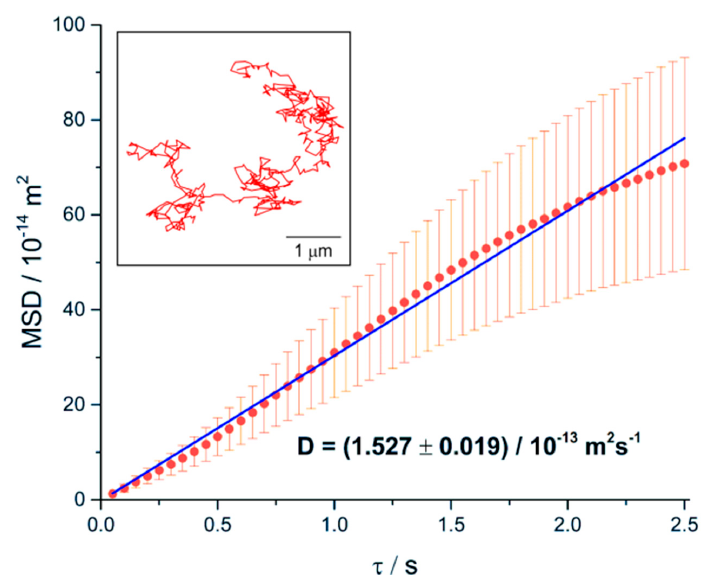
Figure 5. Temporal evolution of the mean square displacement of the center-of-mass of the microgel chain from Figures 3a and 4a. Blue line: linear fit. Inset: single track of the center-of-mass. The corresponding diagrams for the other two examples of microgel chains in Figures 3 and 4 are shown in Figures S3–S6.